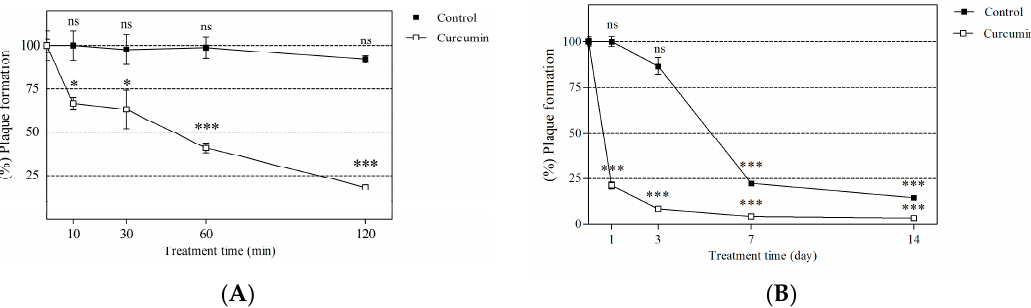
Figure 3. Anti-noroviral efficacy of CCM under short- and long-term incubation in RAW 264.7 cells. MNV was mixed with 1 mg/mL of CCM and stored for ( A ) short (10, 30, 60, and 120 min) and ( B ) long periods (1, 3, 7 and 14 days) at 4 °C. Virus titers were measured by plaque assay (DMSO as a vehicle control). Percentage of plaque formation was compared to the initial time (day 0). Statistical significance was determined based on ANOVA with Bonferroni post-tests. Each point represents the mean ±